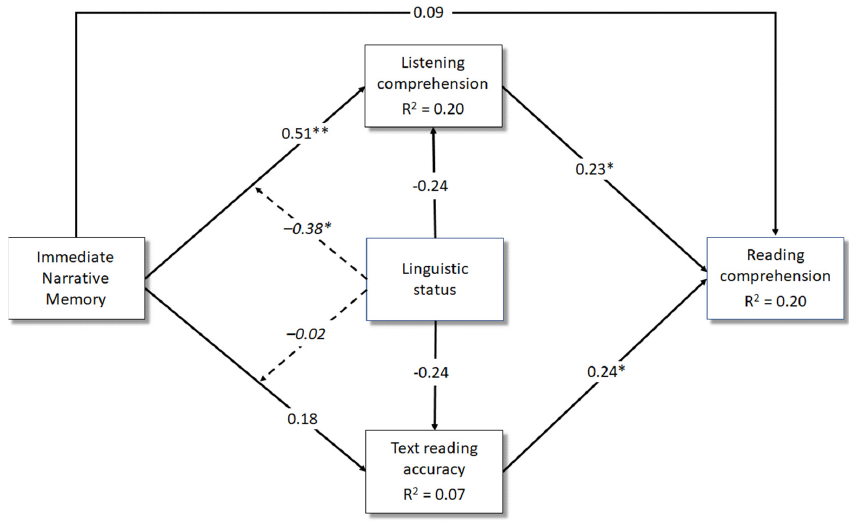
Figure 2. Model 2: A multiple regression analysis including immediate narrative memory (predictor), listening comprehension and reading accuracy (mediators), linguistic status